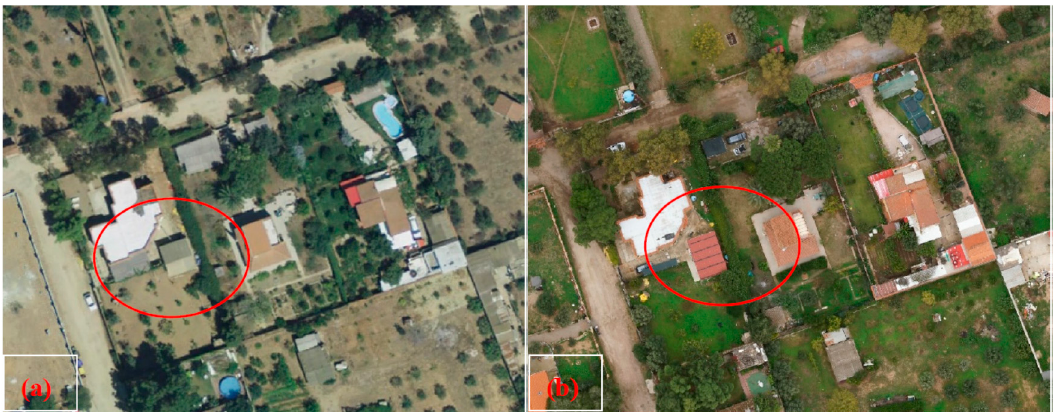
Figure 15. ( a ) Year 2008 orthophoto; and ( b ) year 2016 orthophoto.